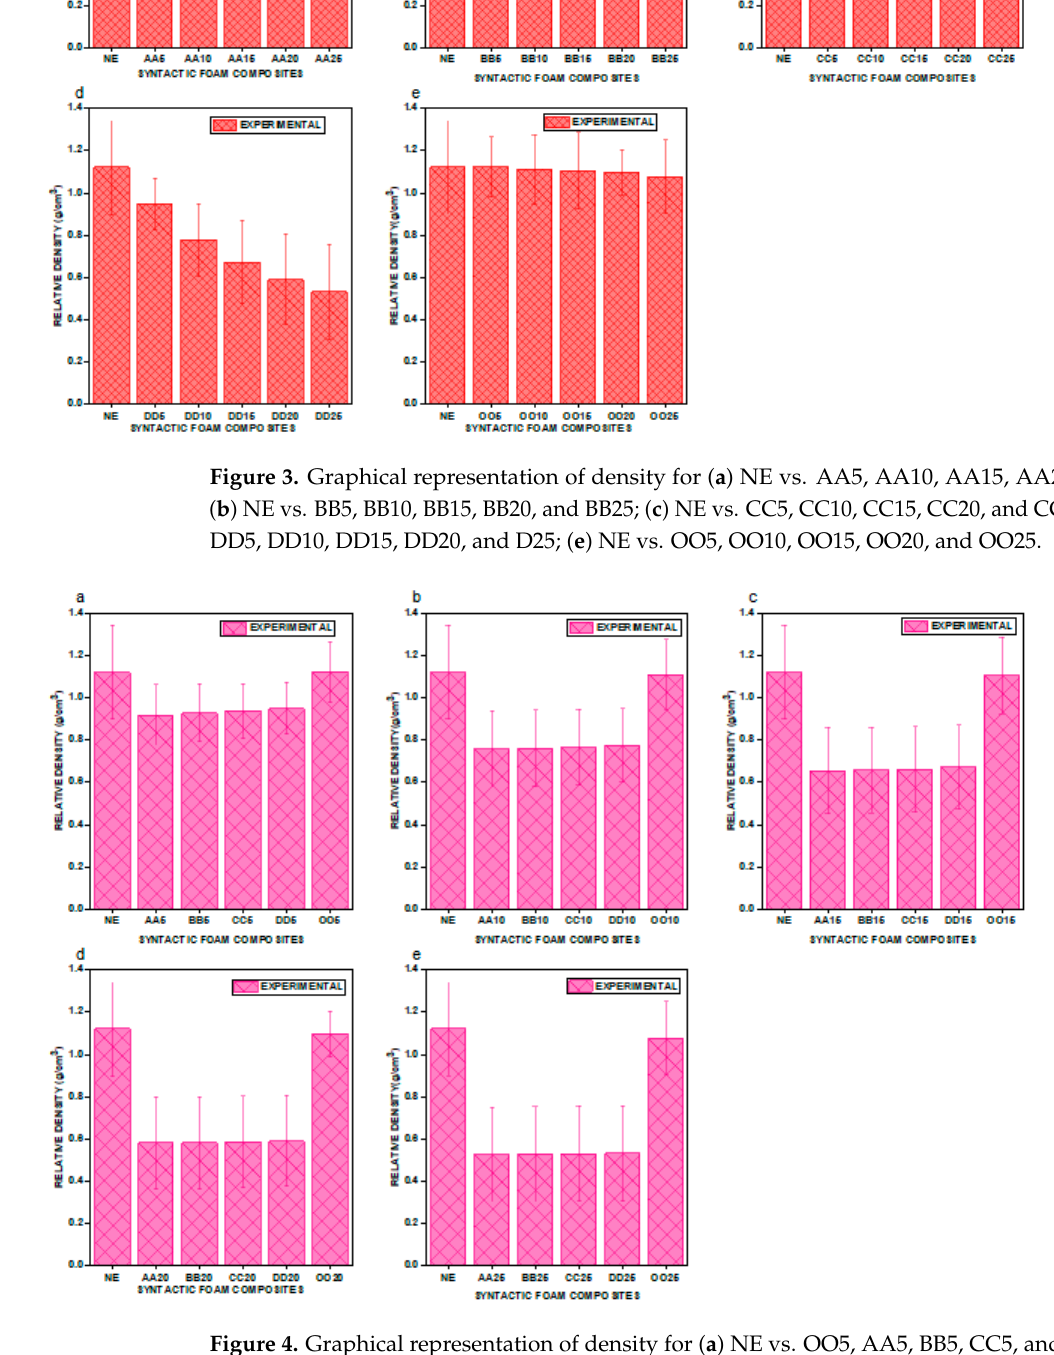
Figure 4. Graphical representation of density for ( a ) NE vs. OO5, AA5, BB5, CC5, and DD5; ( b ) NE vs. OO10, AA10, BB10, CC10, and DD10; ( c ) NE vs. OO15, AA15, BB15, CC15, and DD15; ( d ) NE vs. OO20, AA20, BB20, CC20, and DD20; ( e ) NE vs. OO25, AA25, BB25, CC25, and DD25. The decrease in epoxy matrix vol% and replacement with comparable vol% of HGM creates a porous structure, lowering the density of e–SFCs filled with a uniformly sized HGM [23]. The density values of e–SFCs filled with heterogeneous sizes of HGM are graphically shown in Figure 3e. There is little variation in the density values of e-SFCs filled with heterogeneous sizes of HGM. This may be ascribed to the well-disseminated HGM inside the epoxy matrix, where the gaps between the large-sized HGMs are occu- pied by tiny-sized HGMs, preventing the spaces from being left empty. This can also be attributed to different particle size properties, which invariably affect mixing behavior of the particles [10]. Furthermore, an increase in either particle size or density can result in the rate of segregation of composite materials. Segregation is caused by the generation of vertical driving force on the particles due to their differences in particle size and density [10,24]. From Figure 4a through Figure 4e, an unusual outcome emerges. Compared to NE and e–SFCs filled with heterogeneous sizes of HGMs, there was a drop in density values for the e–SFCs filled equally with HGMs of particular particle sizes [23]. Second, when the concentration of HGM increases, the density value continues to drop, which can be at- tributed to the decrease in epoxy matrix vol% and the replacement with a comparable vol% of HGMs, which creates a porous structure, lowering the density of e–SFCs filled with a particular sized HGM. Although the drop in density is exactly proportional to the concentration, there was a small rise in density with increasing particle size within a given